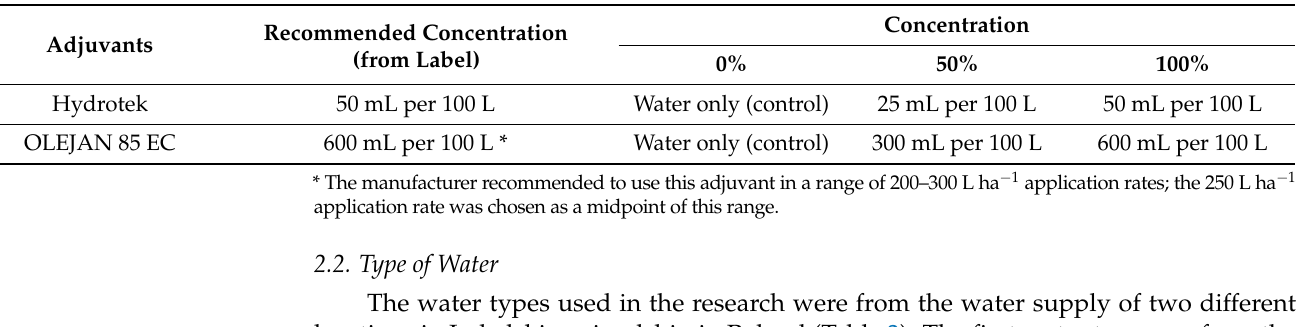
Table 2. Concentrations of adjuvants used in the